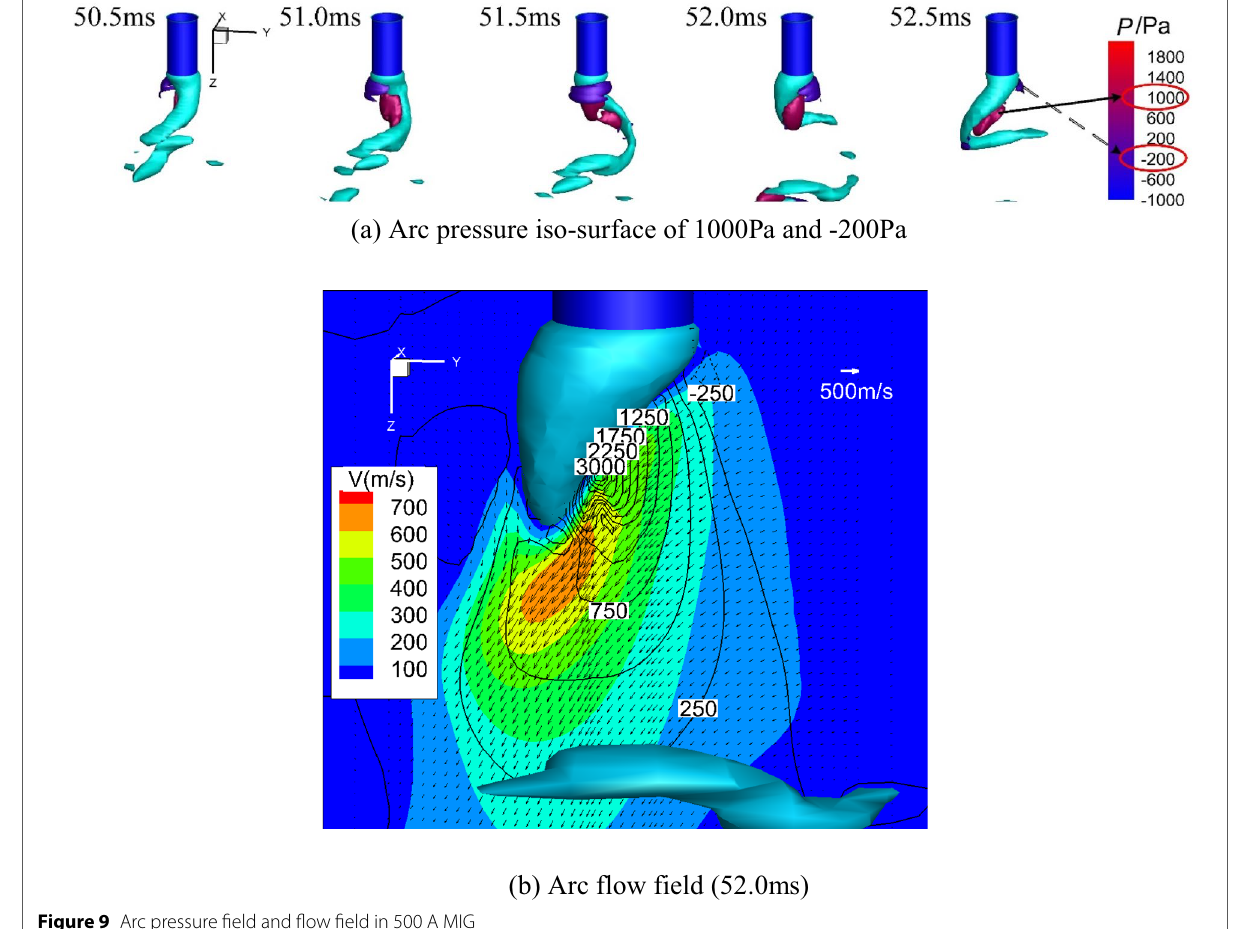
Figure 9 Arc pressure field and flow field in 500 A